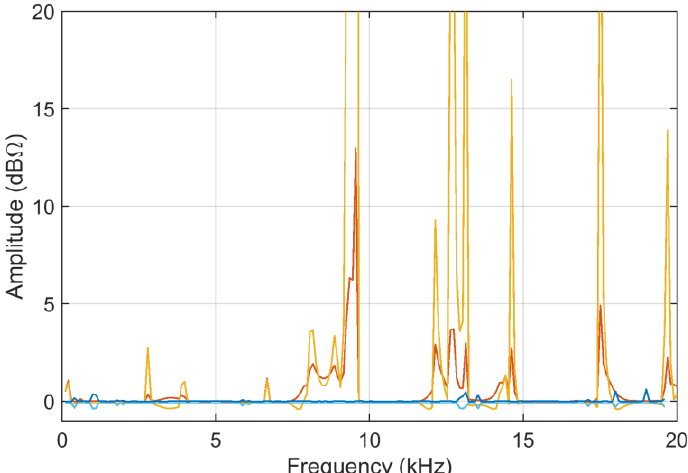
Figure 10. Z (47.5 km) and Z (48.0 km) input data in logarithmic scale: skewness in dark color and kurtosis (offset around 0) in light color for ADM i (orange sk and yellow ku ) and FDM i (blue sk and light blue ku ).